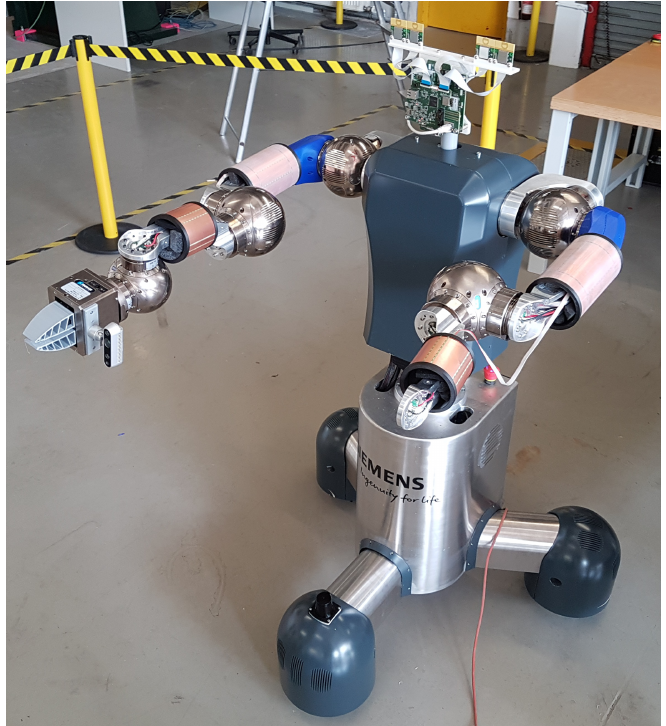
Figure 2. Smart capacitive sensor skin mounted on a robot. Two skin sensors are mounted on the lower arm, two on the upper arm